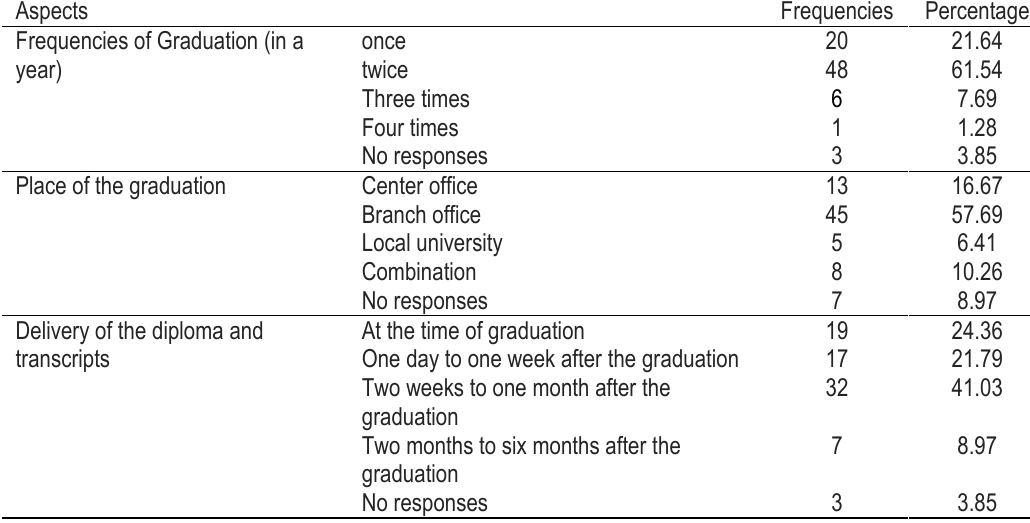
Table 9. Respondents’ Idea on the Certification